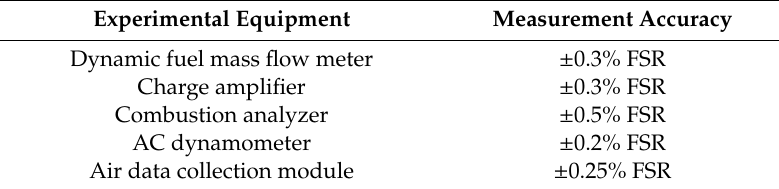
Figure 19. The experiment platform of the initial prototype engine. Table 11. Measurement accuracy specifications of the main experimental